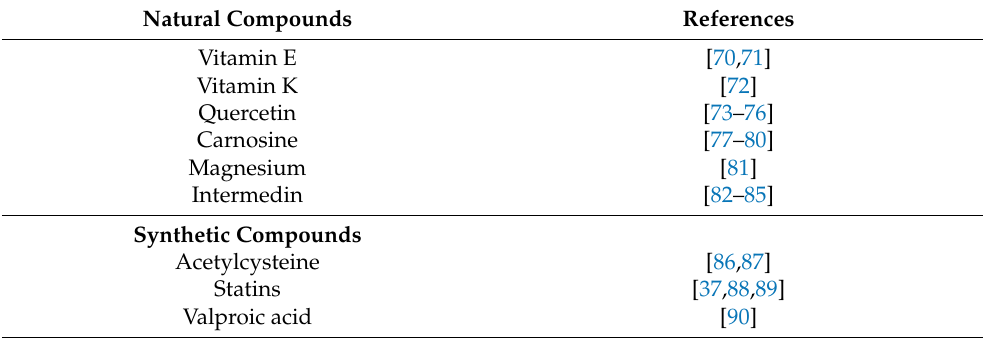
Table 2. Relevant natural and synthetic compounds with anticalcifying properties in in vitro